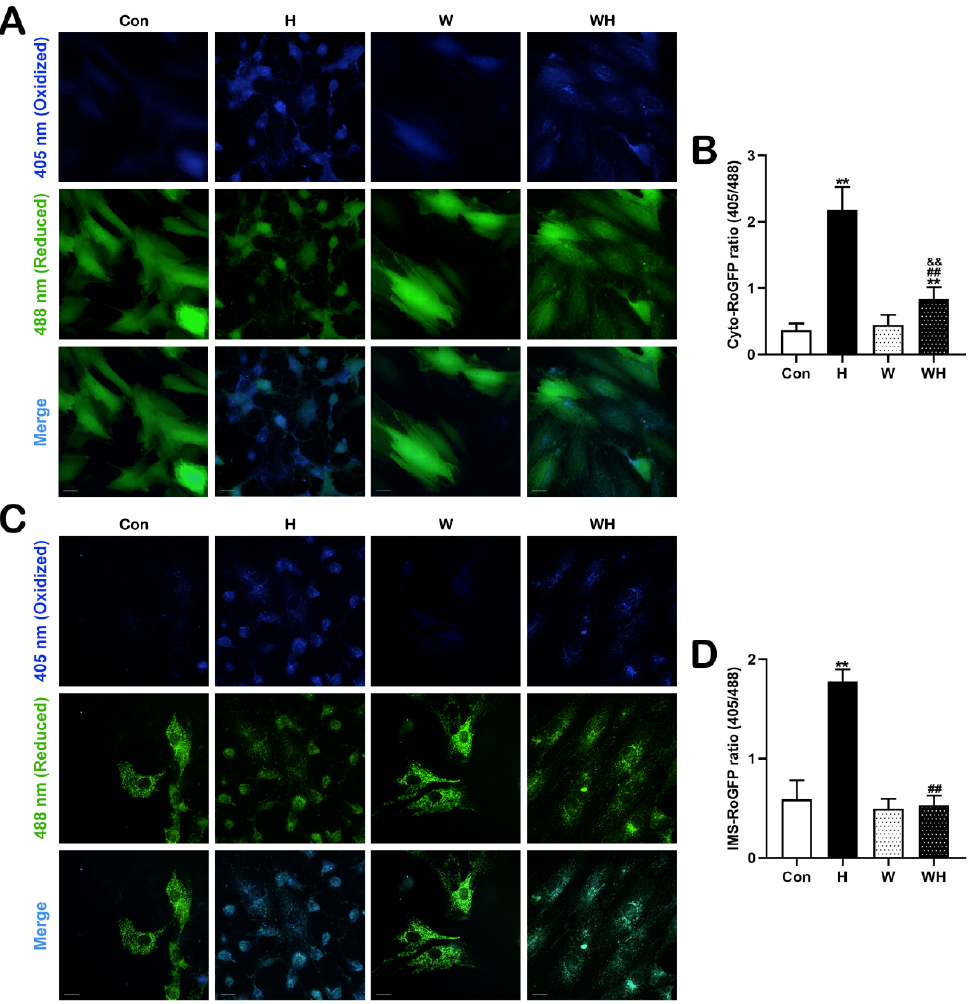
Figure 7. WA reduced ROS production in cardiomyocytes during acute hypoxia. ( A ) Representative immunofluorescence images of cardiomyocytes transfected with Cyto-RoGFP. Excitation at 405 nm and 488 nm indicates the oxidation and reduction states, respectively. ( B ) Quantitative analysis of cytosolic ROS in cardiomyocytes, as reflected by the ratio of the fluorescence intensity at 405 nm to that at 488 nm. Scale bars = 20 µ m. ( C ) Immunofluorescence images of cardiomyocytes transfected with IMS-RoGFP: 405 nm, oxidation; 488 nm, reduction. ( D ) Statistical analysis of IMS ROS, as reflected by the ratio of the fluorescence intensity at 405 nm to that at 488 nm. Scale bars = 20 µ m. The data are presented as the mean ± SEM values; n > 20 fields from three independent